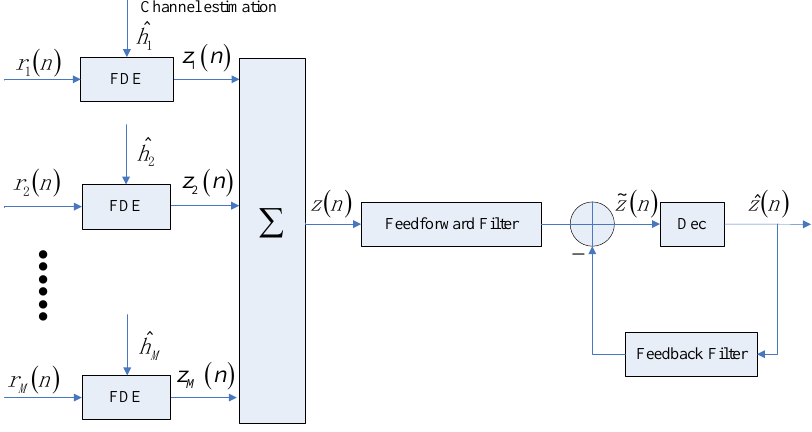
Figure 3. Hybrid time frequency domain equalizer